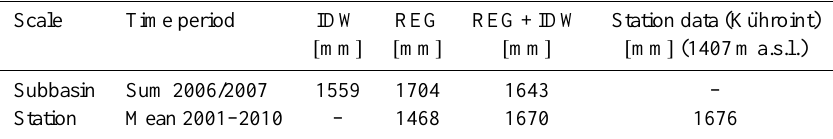
Table 2. Pecipitation interpolation analysis.